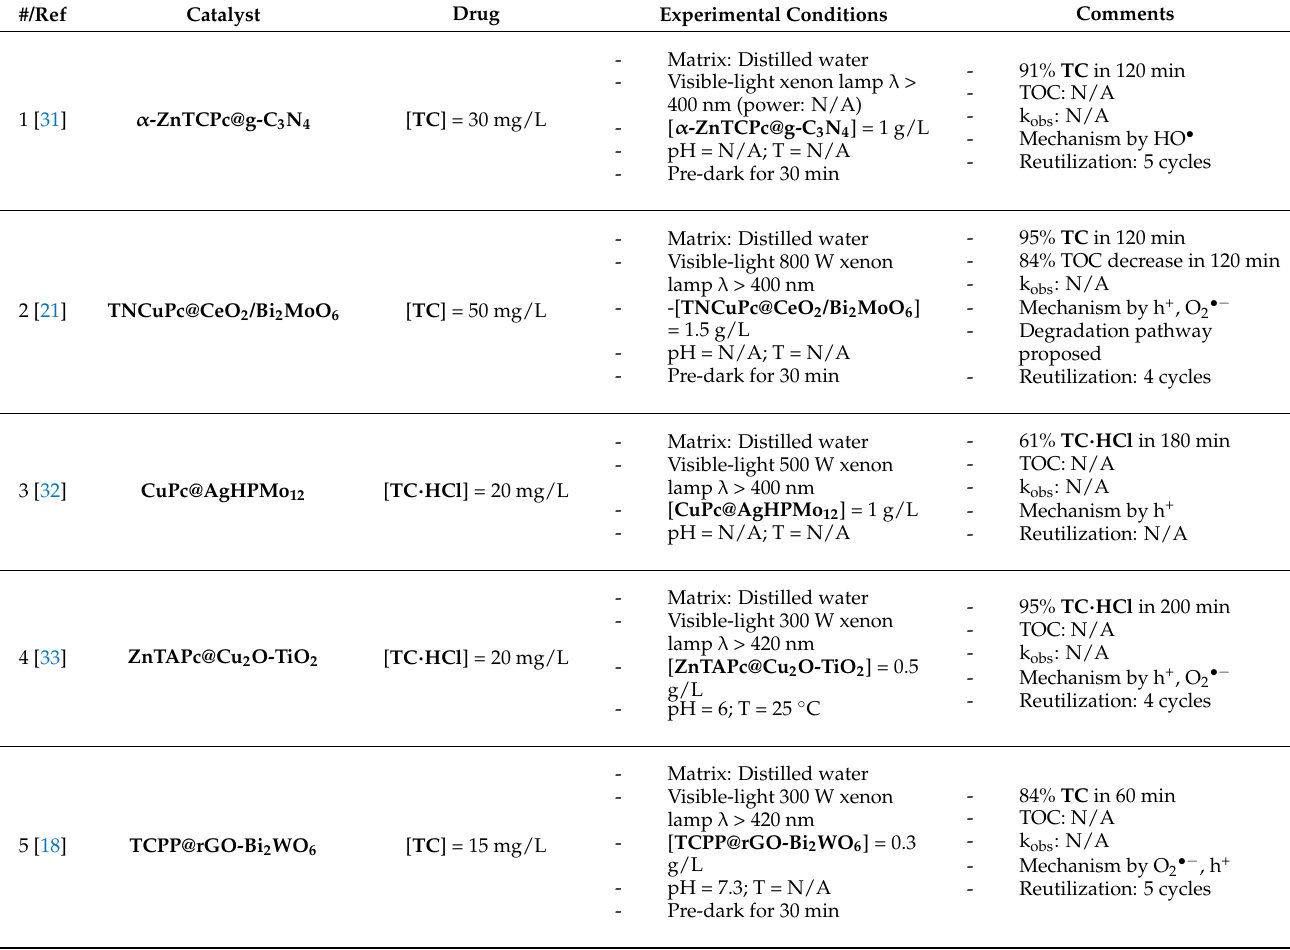
Table 1. Photochemical degradation of antibiotics using TPM-based